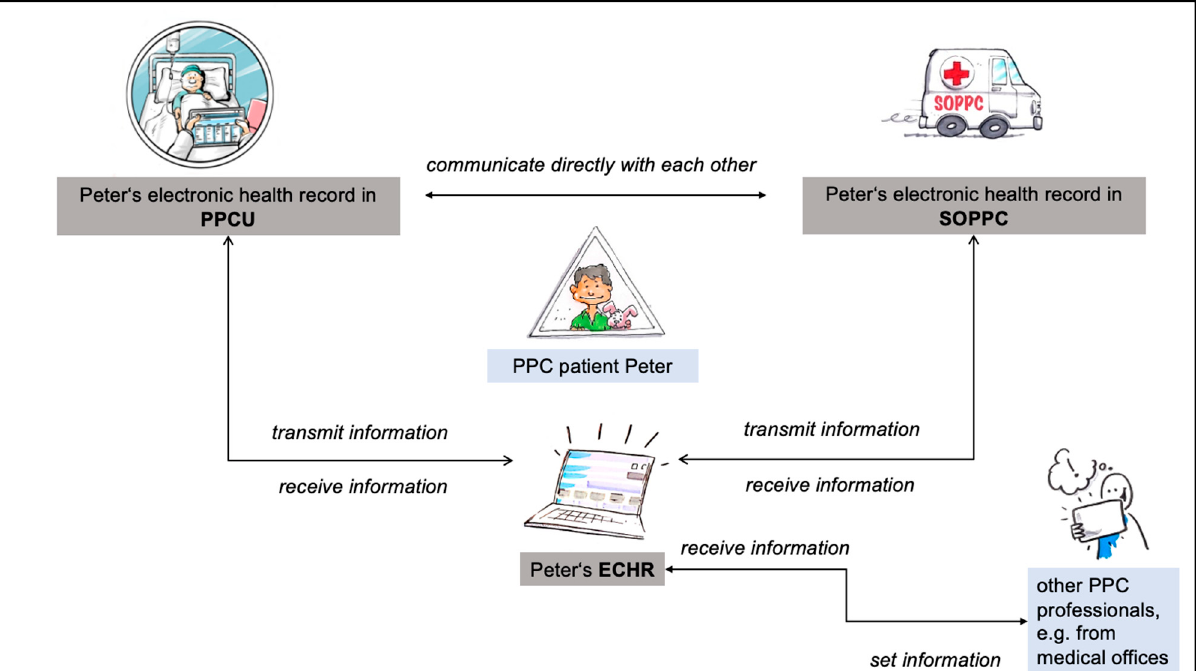
Figure 1. Data exchange between PPCU, SOPPC, and ECHR (drawings by Dagmar Gosejacob and Ralf Marczinczik for the project).